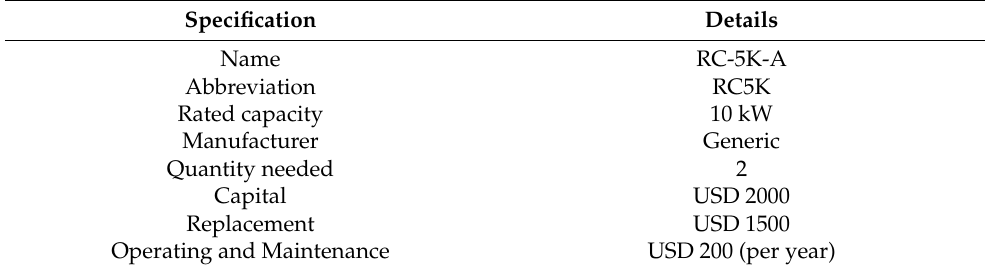
Table 3. Selected wind turbine specification.